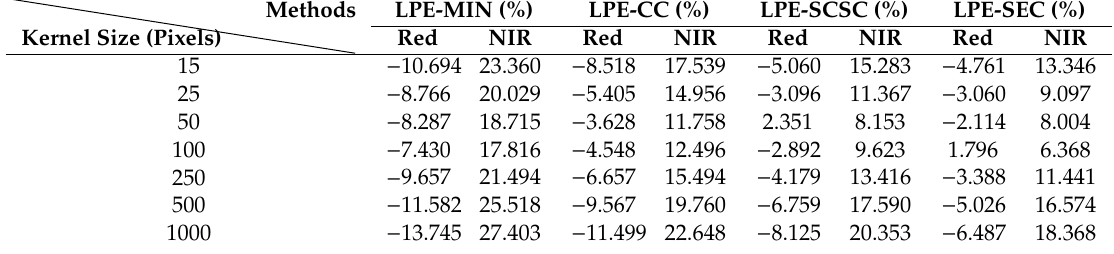
Table 3. The reflectance di ff erence of the coniferous forests on sunlit-shaded slopes using the LPE-TC models with the kernel sizes ranging from 15 pixels to 1000 pixels.